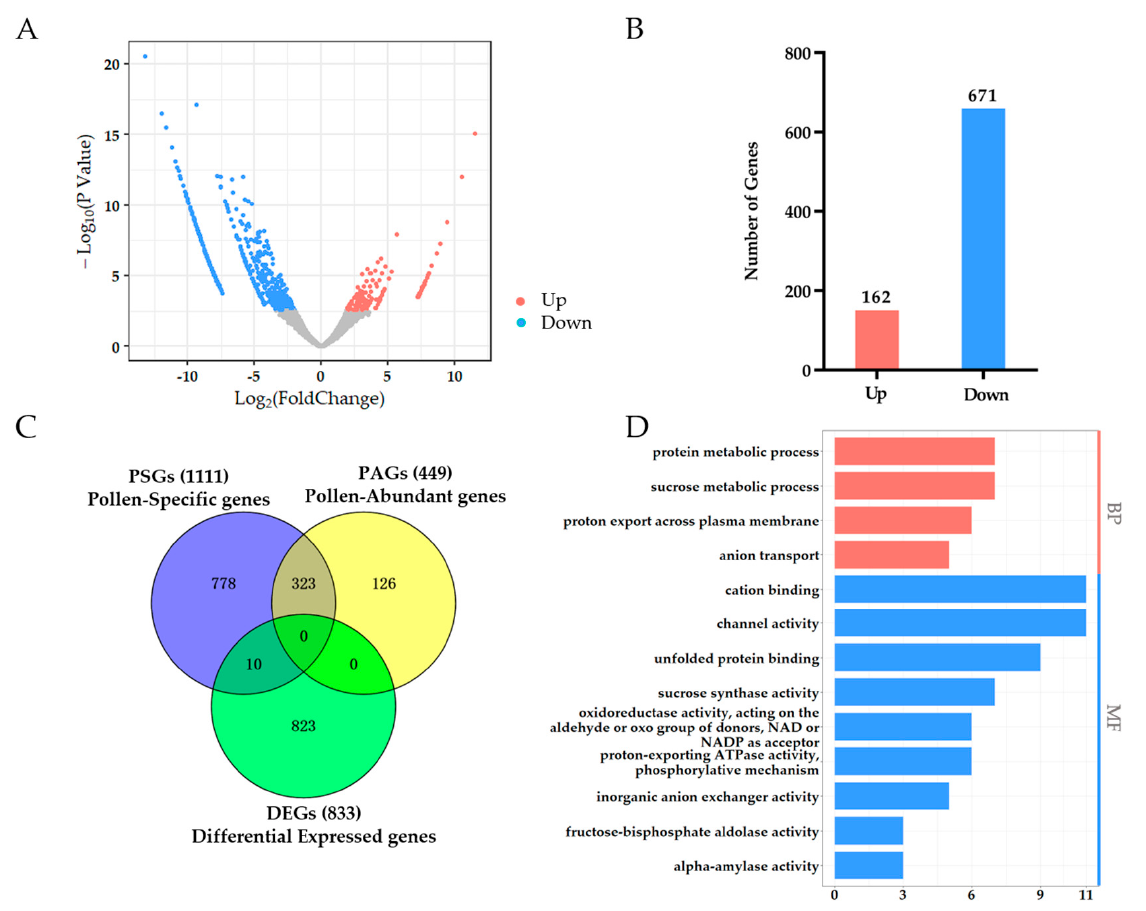
Figure 8. Volcano plot, Venny plot, and GO enrichment analysis of differentially expressed genes (DEGs). ( A ) Volcano plot of DEGs, the x-axis indicates the value of log 2 (FoldChange) and the y-axis indicates the value of − log10 ( p -value); ( B ) Number of up-regulated genes and down-regulated genes; ( C ) Venny plot of PSGs, PAGs, and DEGs; ( D ) GO enrichment analysis of DEGs, the x-axis represents the gene number assigned to a GO term and the y-axis is the list of significantly enriched GO terms.